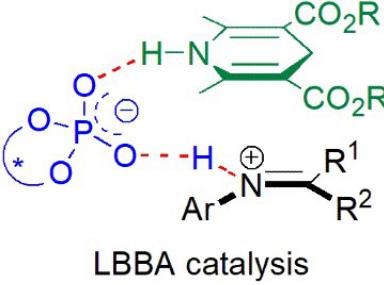
Figure 10. Complexation between the catalyst and the reagents in LBBA catalysis in the ETH of quinolines. The secondary (non-covalent) interactions are not shown [58].